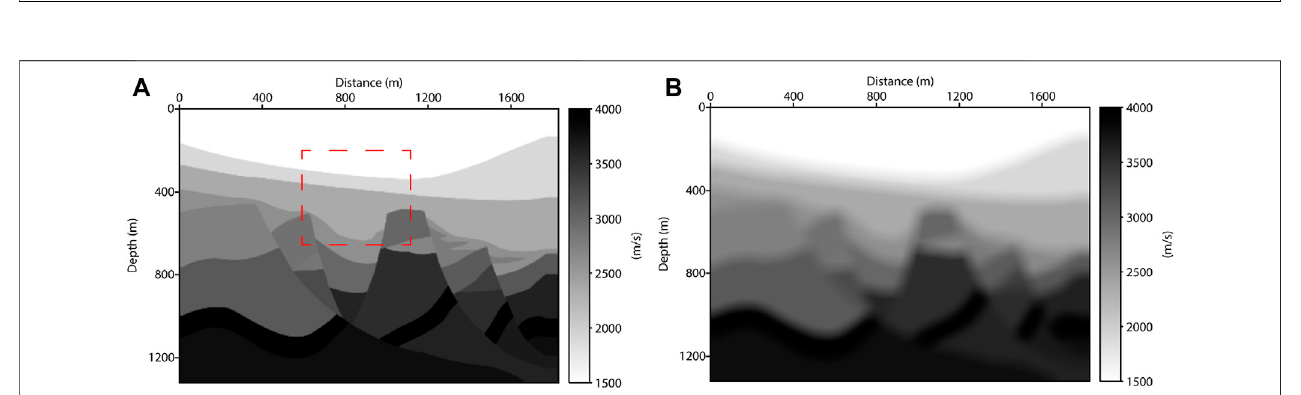
FIGURE 6 | (A) The real velocity of fault model. (B) the background velocity model after smooth.